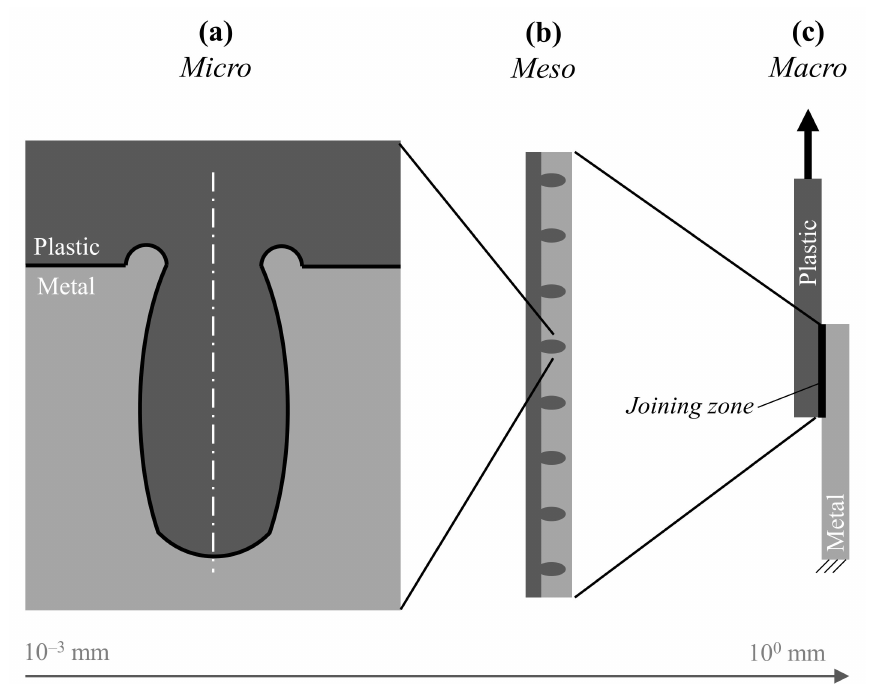
Figure 1. Characteristic levels for laser-based plastic-metal hybrid joints. Micro level ( a ) describes the properties of a single cavity. Meso level ( b ) describes the properties of multiple cavities, and macro level ( c ) describes the properties of the joining